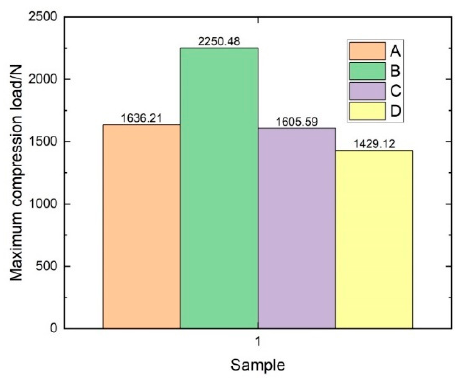
Figure 22. Maximum weft compression load diagram.